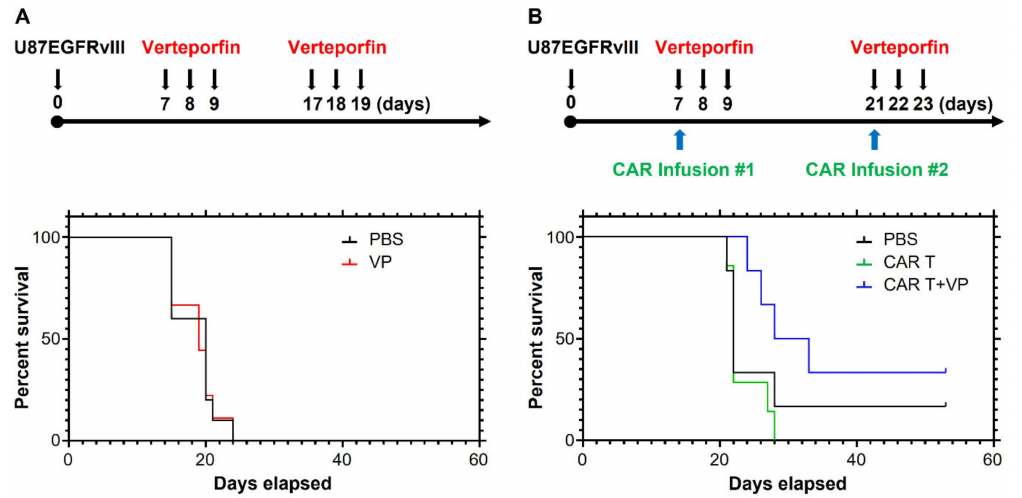
Figure 8. Verteporfin reverses CAR dysfunction. ( A ) Treatment schema and survival curves of mice bearing U87-EGFRvII tumor treated with or without verteporfin, median survival 17 days (PBS and VP). ( B ) Treatment schema and survival curves of mice bearing U87-EGFRvIII tumors treated with Donor 1 CAR with or without verteporfin, median survival 22 (PBS), 22 (CAR T), and 30.5 days (CAR T+VP). If the mouse was moribund or dead, it did not receive the second CAR